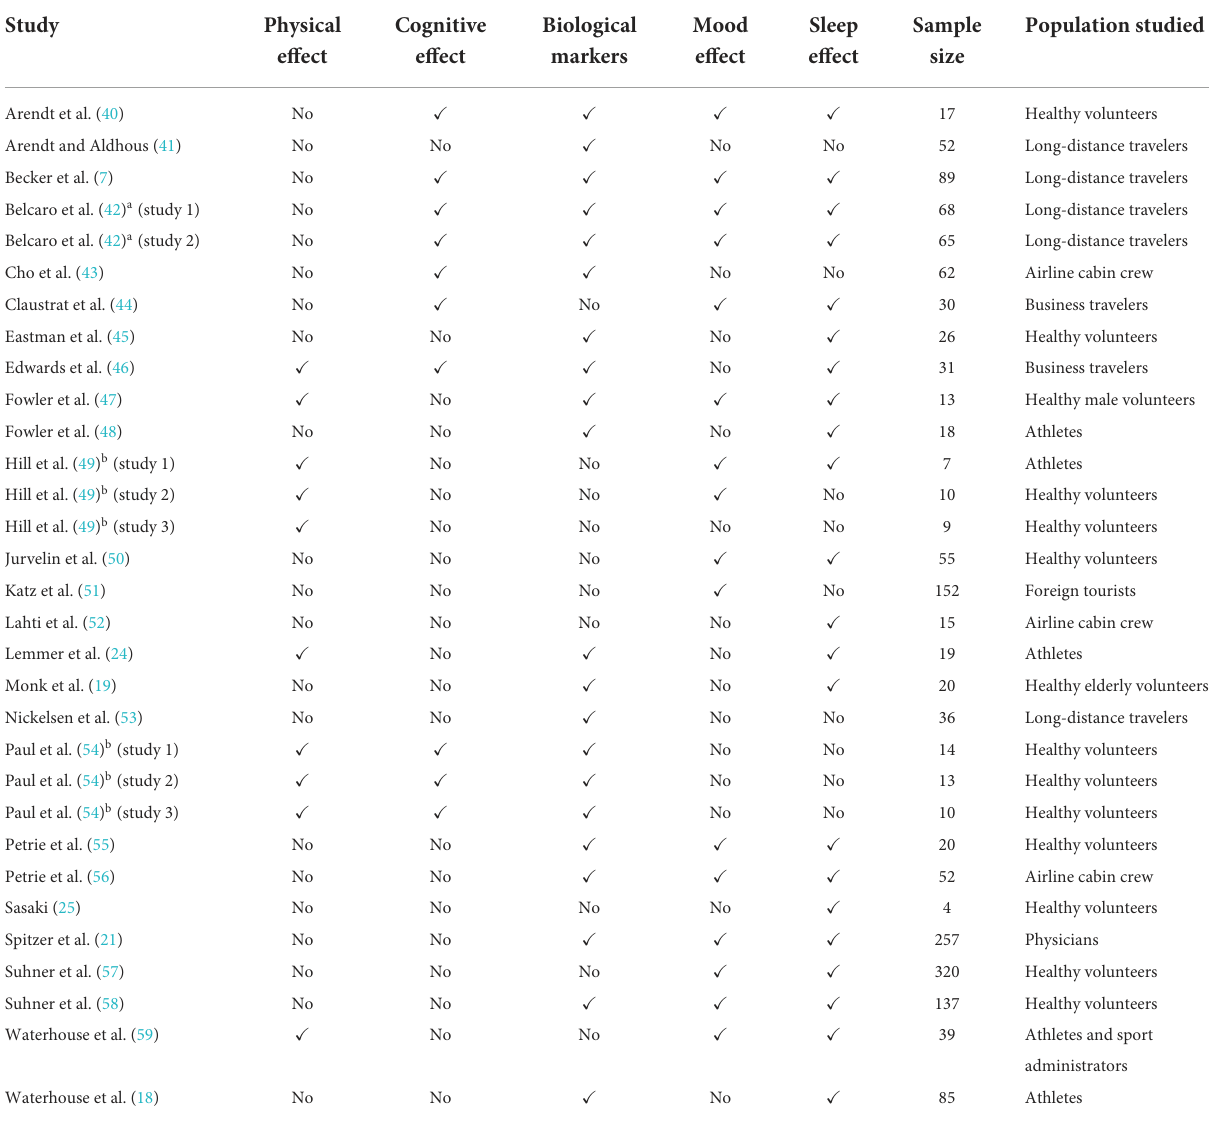
margin of five British gold medals being silver medals was only 0.545 s—that shows how close it can be” (33).